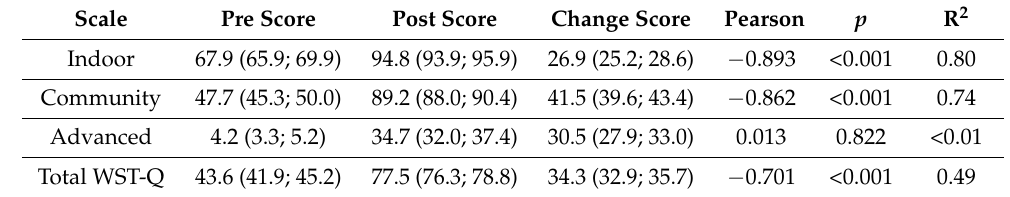
Table 2. WST-Q subscale mean % score (95% CI) and correlation between pre and change score 1 .